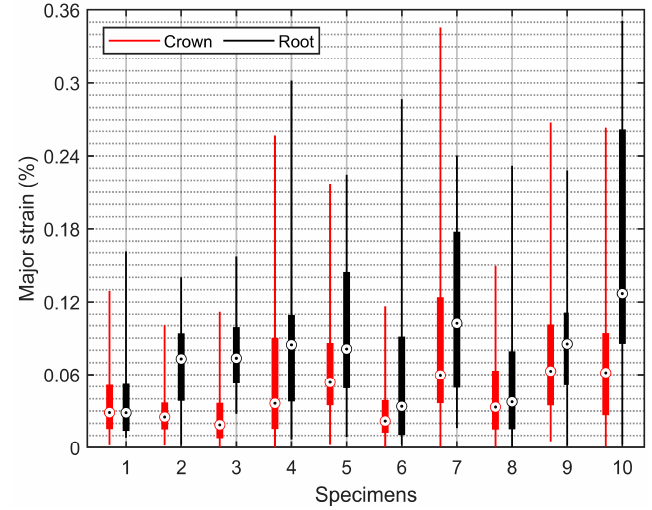
Figure 9. Box plot of the major strains in the crown and the root of specimens. Boxes are composed of the minimum, first quartile, third quartile, median, and maximum strain values.